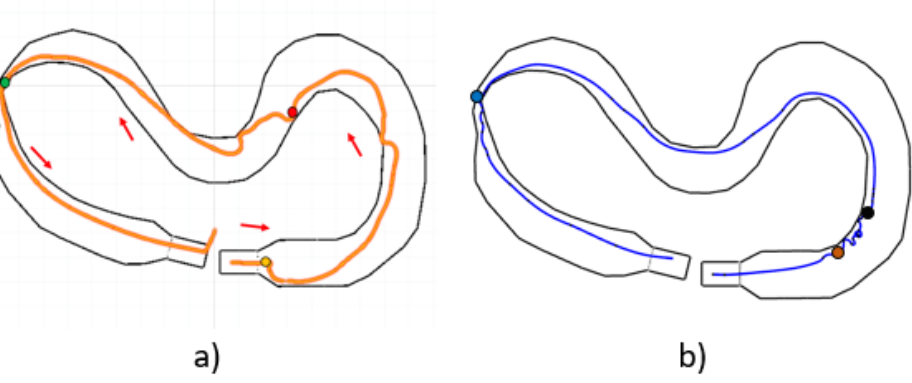
Figure 14. Trajectory through the experimental track: P15 at a) and P10 at